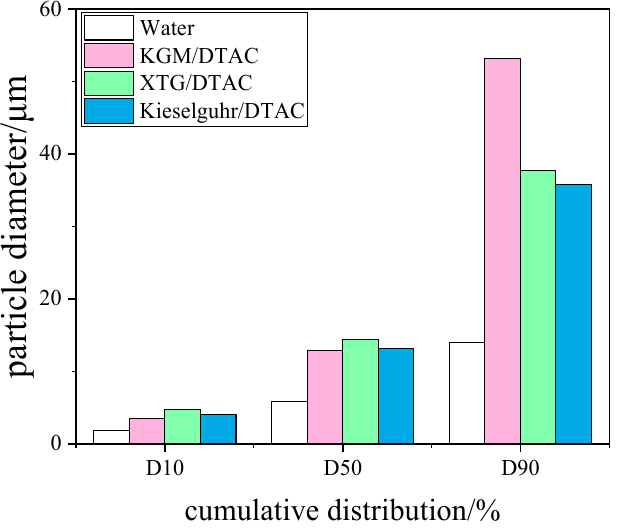
Figure 13. Histogram of cumulative particle size distribution of the synergistic effect of surfactant and coagulant.